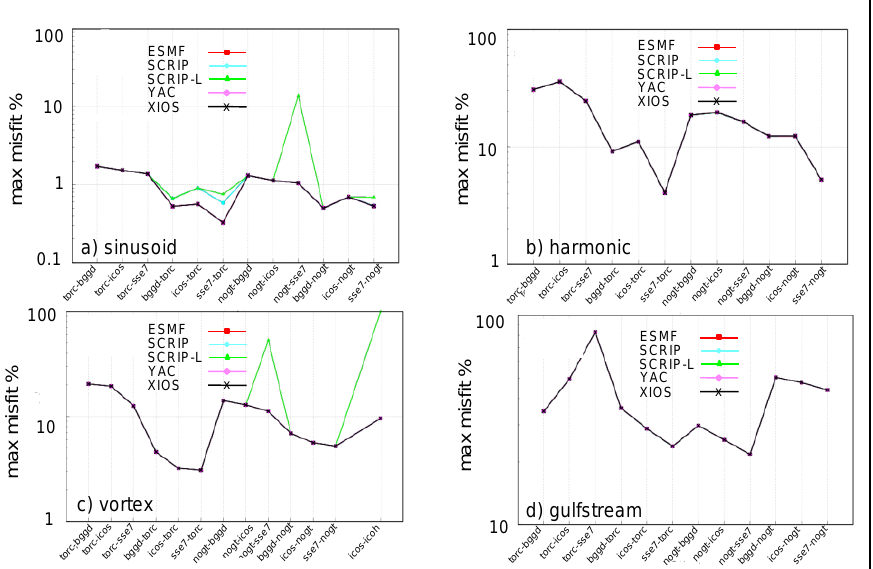
Figure 13. Maximum misfit for ESMF, SCRIP, SCRIP-L, YAC, and XIOS for the first-order conserva- tive remapping with FRACAREA normalisation for the different pairs of grids for the 4 functions: ( a ) sinusoid , ( b ) harmonic , ( c ) vortex , ( d ) gulfstream .